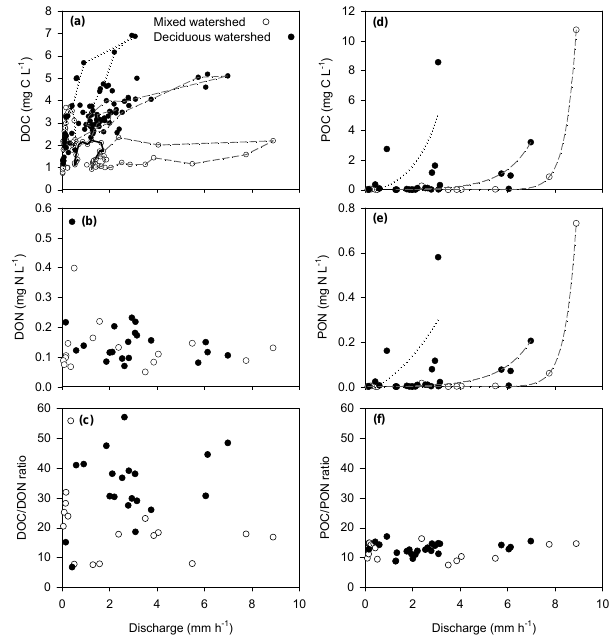
Figure 3. Concentrations of (a) dissolved organic carbon (DOC) and (b) nitrogen (DON), (d) particulate organic carbon (POC), and (e) nitrogen (PON) and the ratios of (c) DOC / DON and (f) POC / PON in runoff with discharge during monsoon storm events. Doted, solid, and dashed lines correspond to the storm event of 8, 11, and 14 July 2013, respectively.